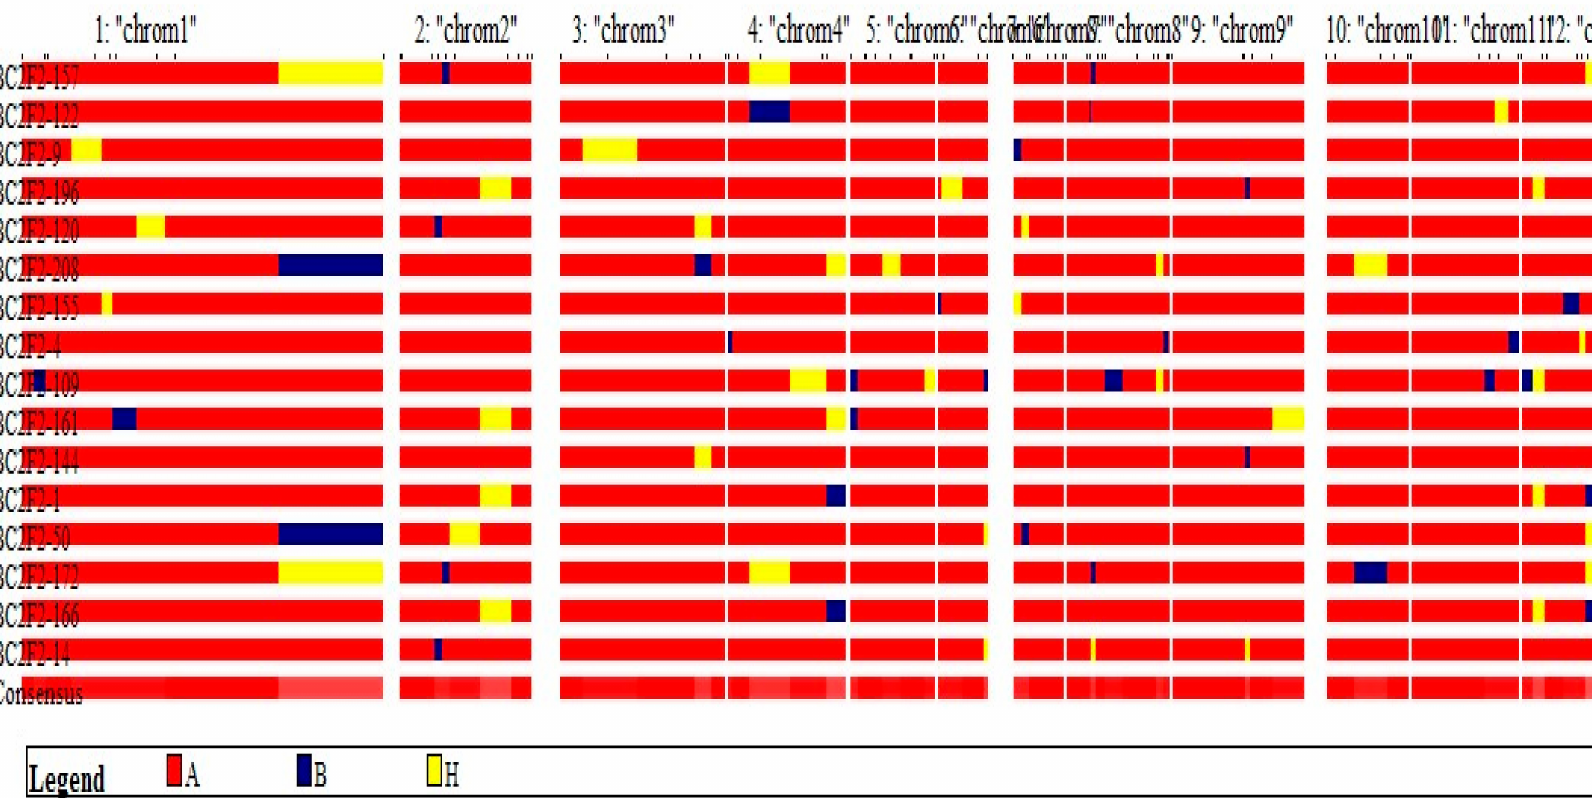
Figure 5. Chromosome-wise RPGR of 16 improved lines.Note: Red lines represent homozygous region for Putra-1 alleles, blue lines represent homozygous regions for IRBB60 alleles while yellow lines represent heterozygous